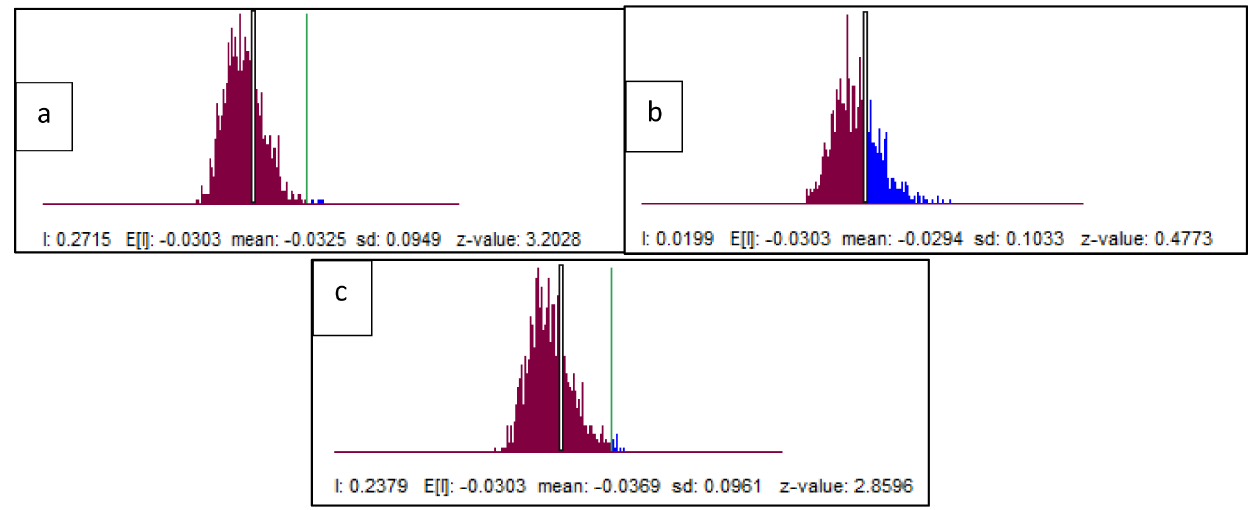
Figure 7. Spatial autocorrelation illustration of dentists per area ( a ), dental therapists per area ( b ), and dental technicians per area ( c ). The plots show the spatial autocorrelation between the number of dentists and dental therapists per area in every province in Indonesia. But the dental technician is not showing the spatial